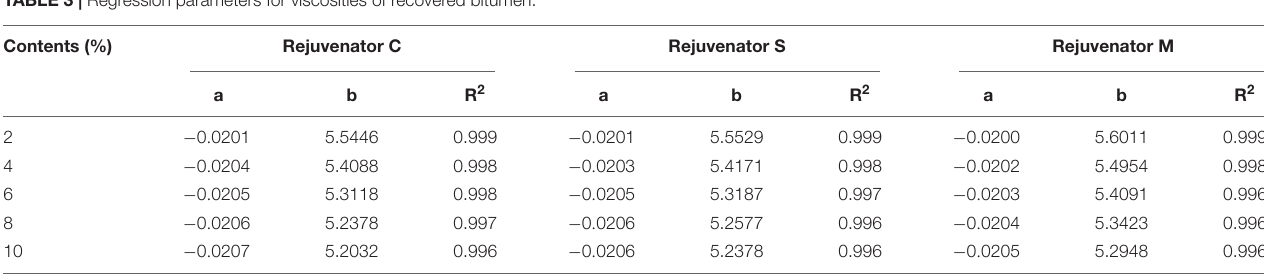
TABLE 3 | Regression parameters for viscosities of recovered